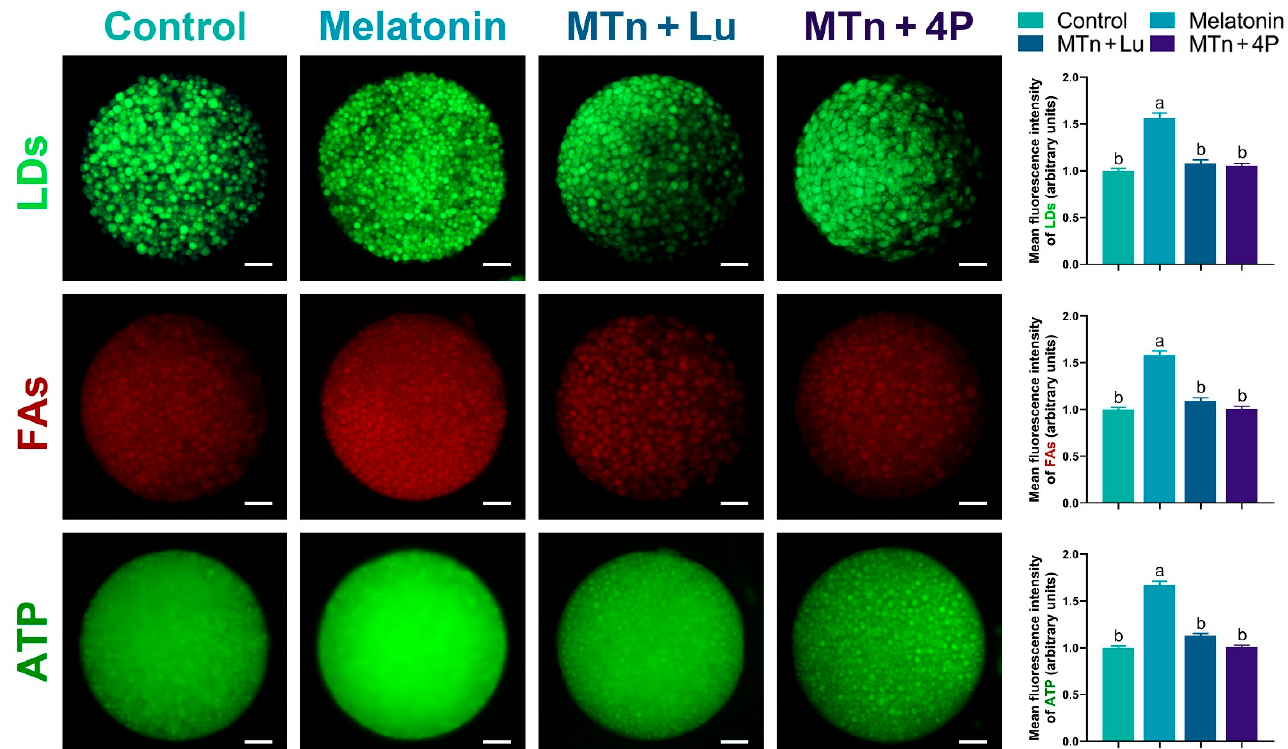
Figure 7. The levels of LDs, FAs and ATP in oocytes. Melatonin/MTn, 10 − 9 mol/L melatonin; Luzindole/Lu, 10 − 9 mol/L Luzindole; 4P-PDOT/4P, 10 − 9 mol/L 4P-PDOT. Scale bar = 25 µ m. Different letters denote significant difference ( p < 0.05).